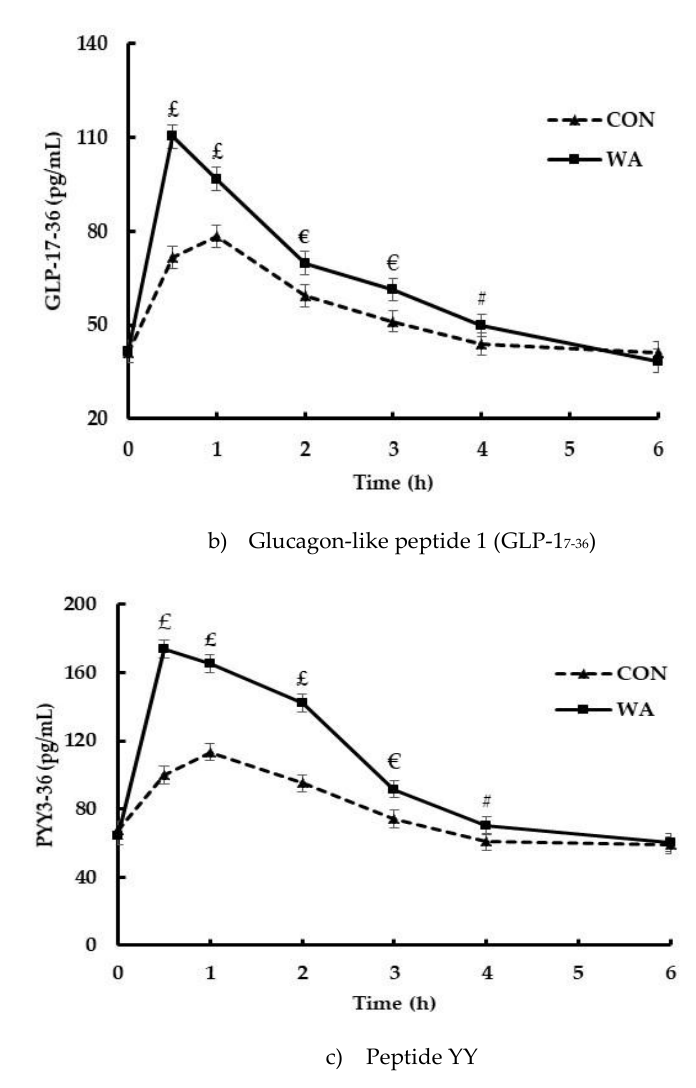
Figure 4. Postprandial profiles of: ( a ) total ghrelin, ( b ) Glucagon-like peptide, GLP-1 7-36 , ( c ) peptide YY, PYY 3-36 after consumption of avocado or control meals (WA or CON, respectively). Data were analyzed by PROC MIXED using SAS 9.4. Main effects meal p < 0.01, time p < 0.01, and meal by time p < 0.01 were observed. #, €, £ Level of significance between treatments at each time point, # p < 0.05, € p < 0.01, £ p < 0.0005. Data are means ± SE, n = 31. Abbreviations: CON, Control meal; HA, Half Hass Table 3. Gut peptide and insulin hormone iAUC over 6-hour postprandial day 1 .